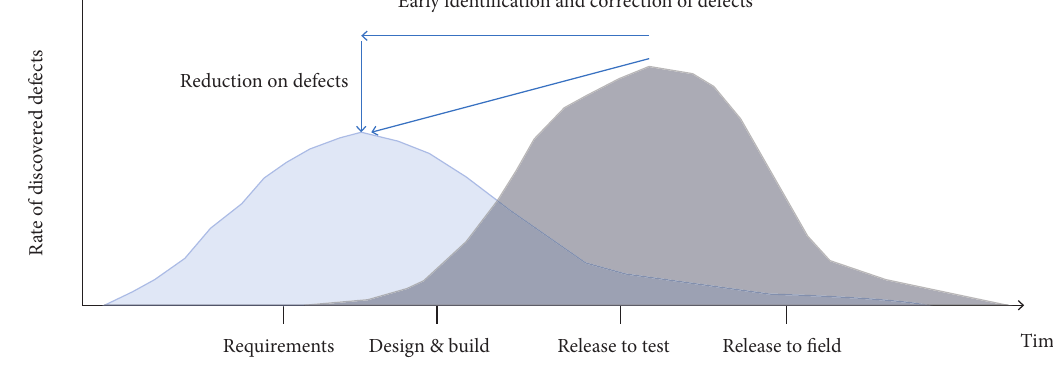
Figure 1. A necessary product development process shift for decreasing defect